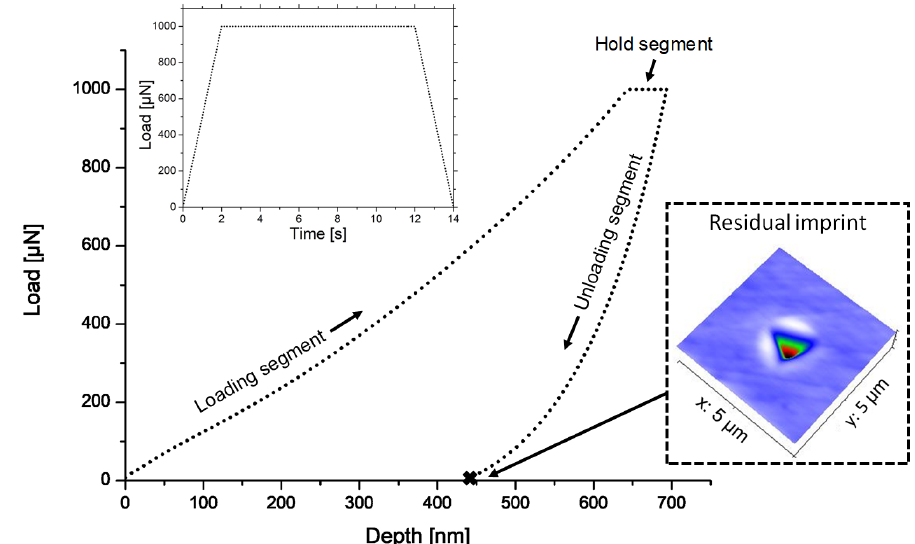
Figure 3. Example of a load-displacement curve, its trapezoidal loading profile and a 3-D-view of the resulting indent.